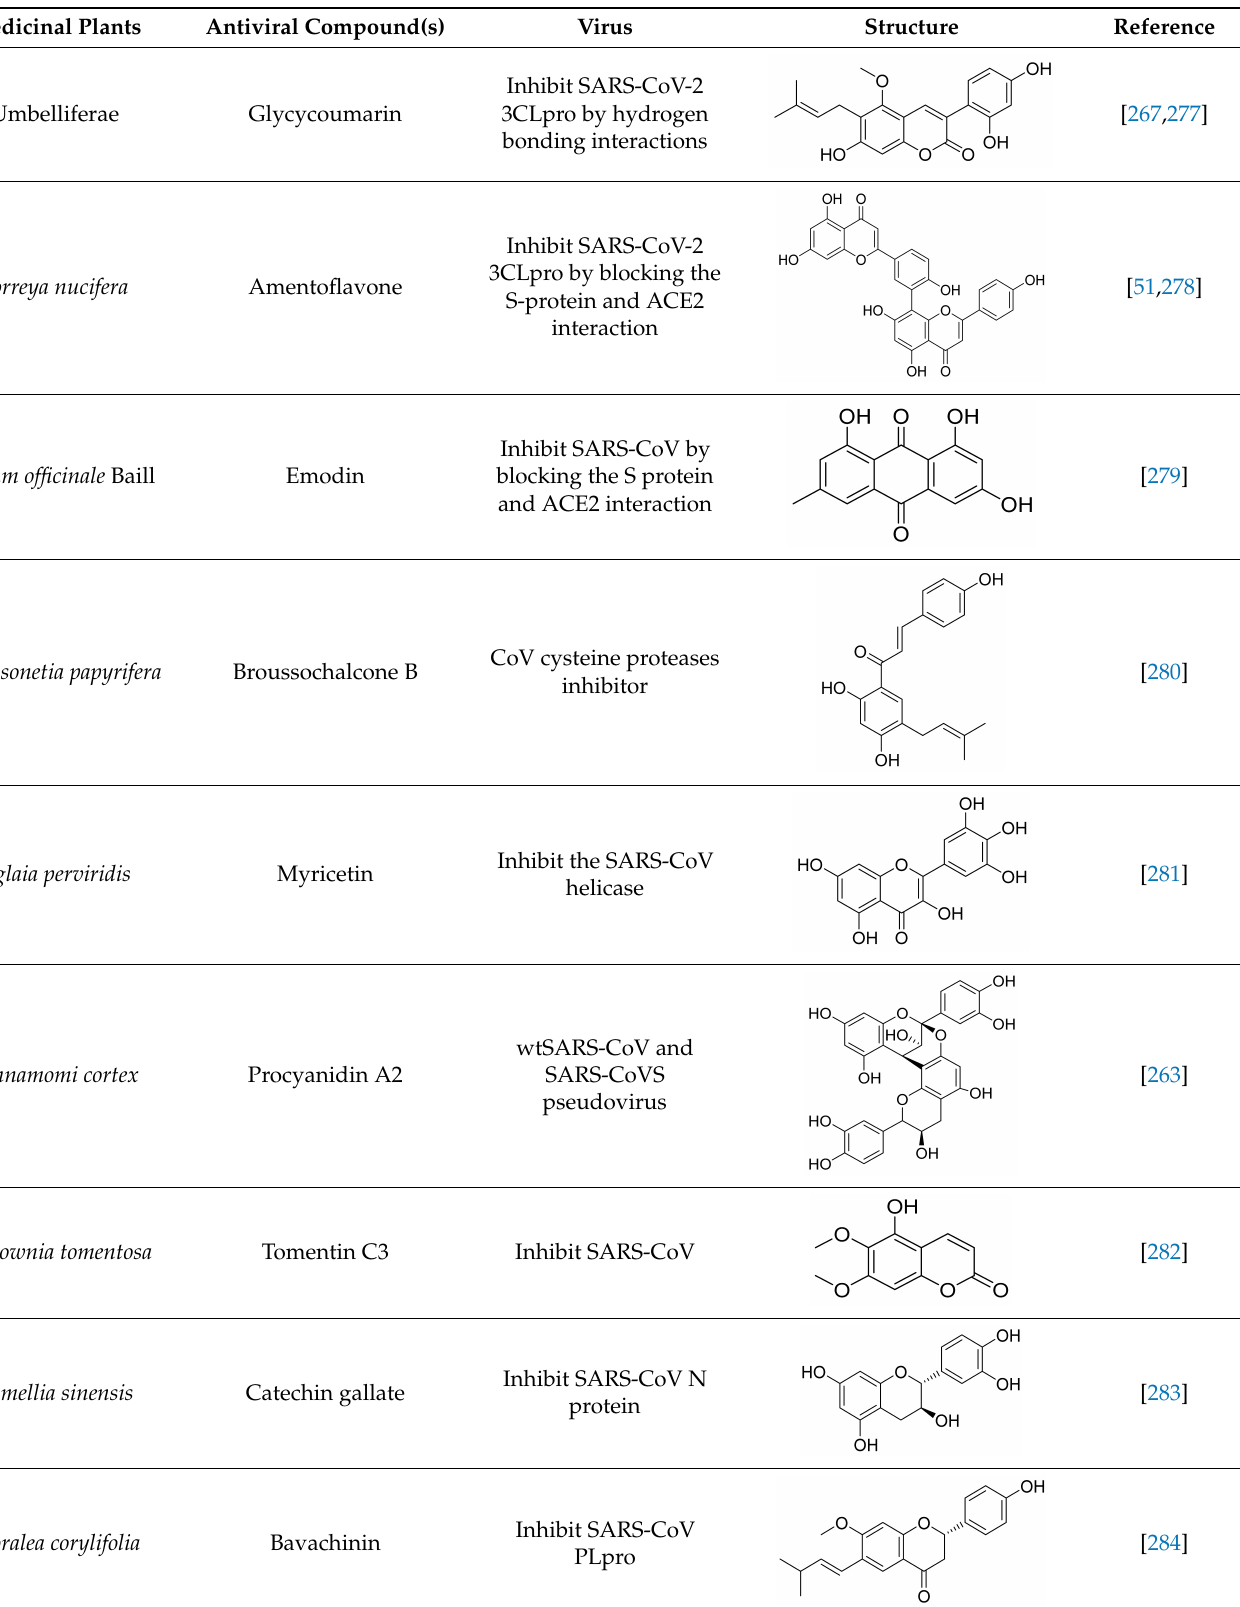
Table 7. Selected antiviral plants targeting coronaviruses